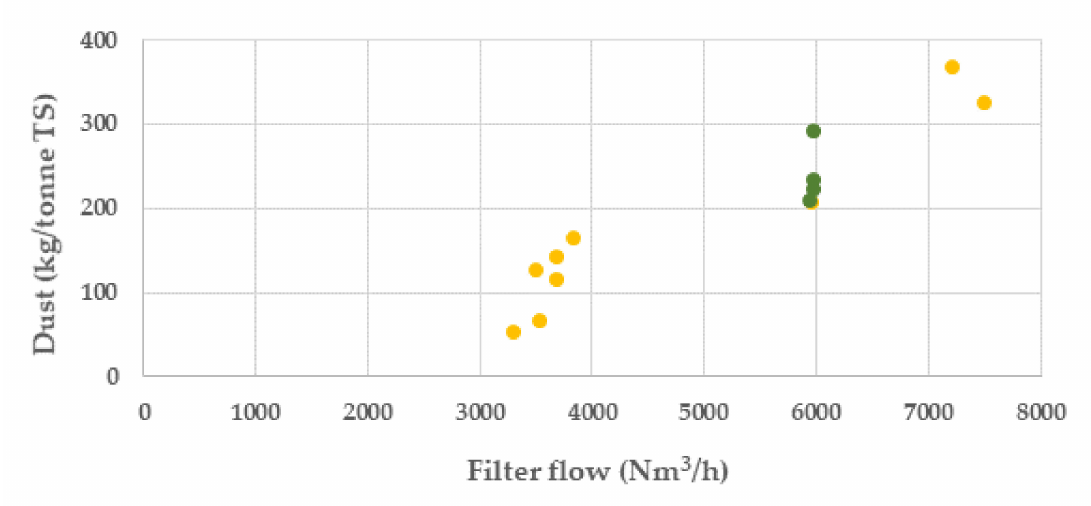
Figure 8. Dust generation in batches in kilo per tonne dry BF sludge at di ff erent filter flow rates (Nm 3 / h) (campaign 1, yellow colour and campaign 2 green